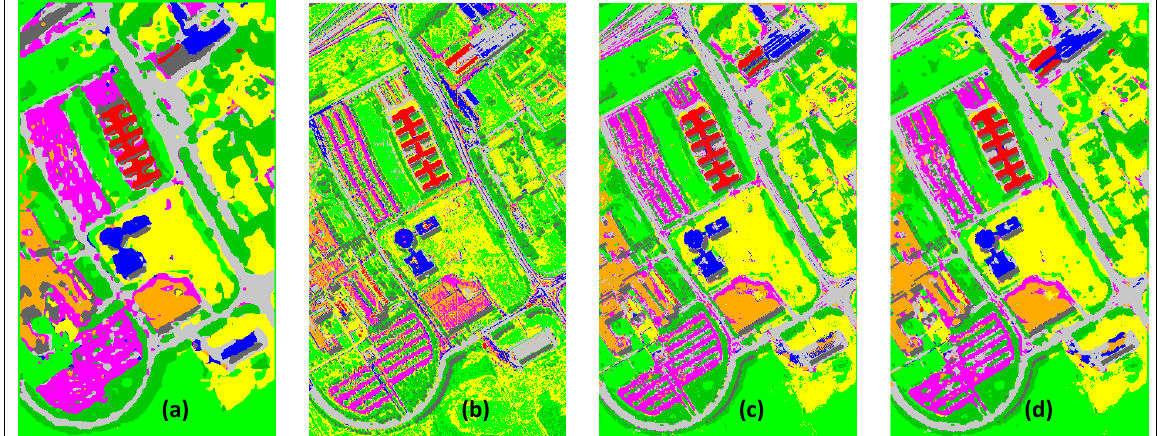
Figure 3. Pavia University classification results using the best decision fusion rule; (a) SVM classification of HS image, (b) SVM classification of MS image, (c) Classification fusion by Min rule, (d) Global classification regularization.